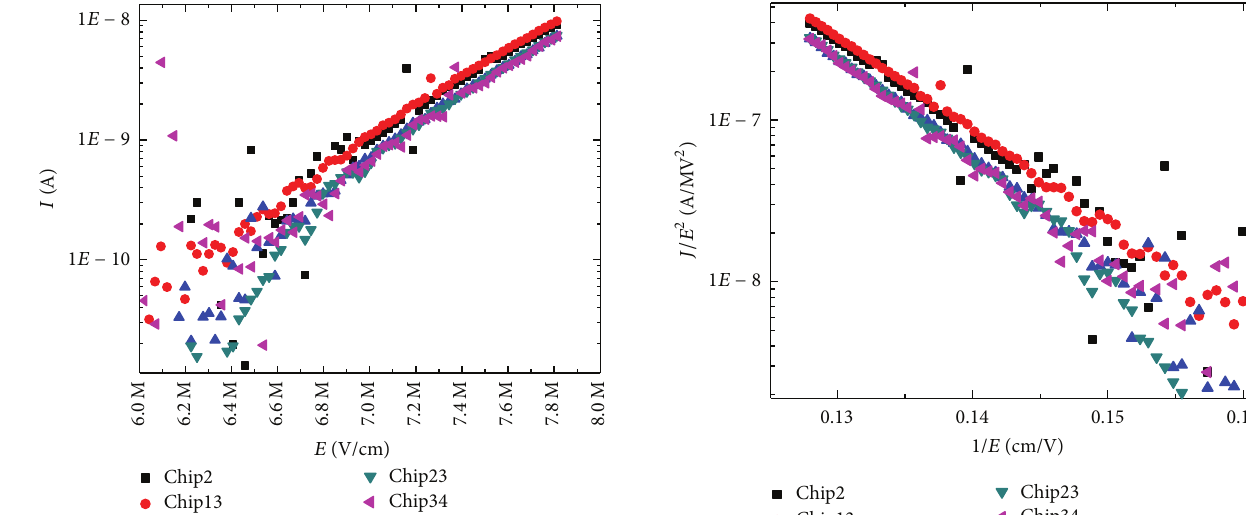
uses high drain voltages to induce the HEI mechanism in order to increase the electron charge onto the floating gate.